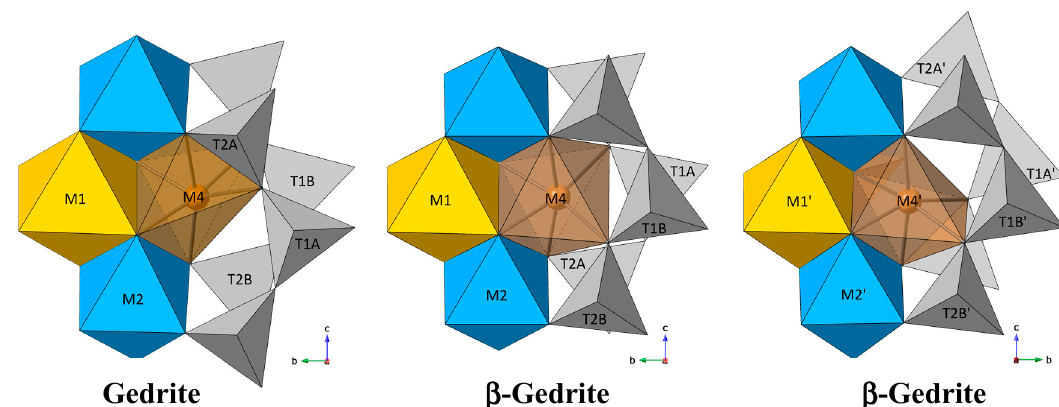
Figure 4. M4 polyhedral configuration in gedrite. The M4 polyhedron in β -gedrite is no longer sharing any edges with adjacent tetrahedra from the double-chains.